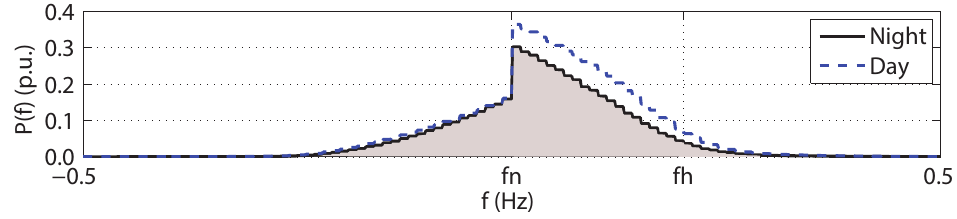
Figure 9. Occurrence probability during the day and night of a frequency disturbance in SING power grid.